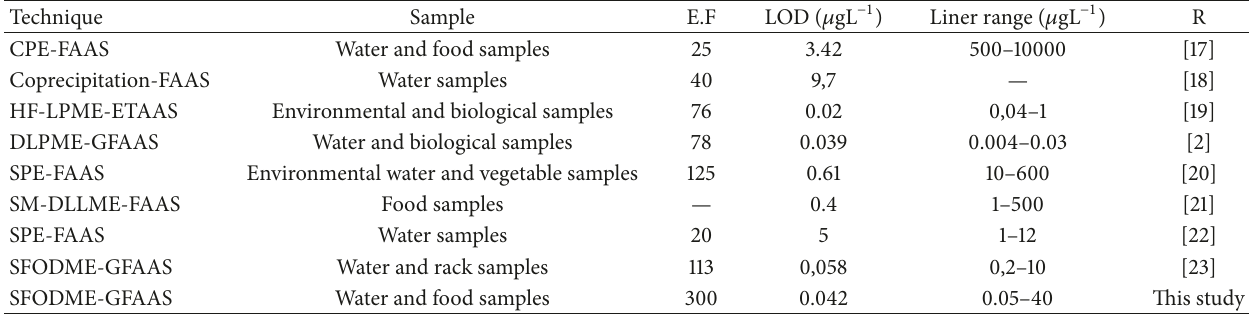
Table 5: Comparison of the SFODM method with some recent studies on separation and preconcentration of Pb(II) ions reported in the